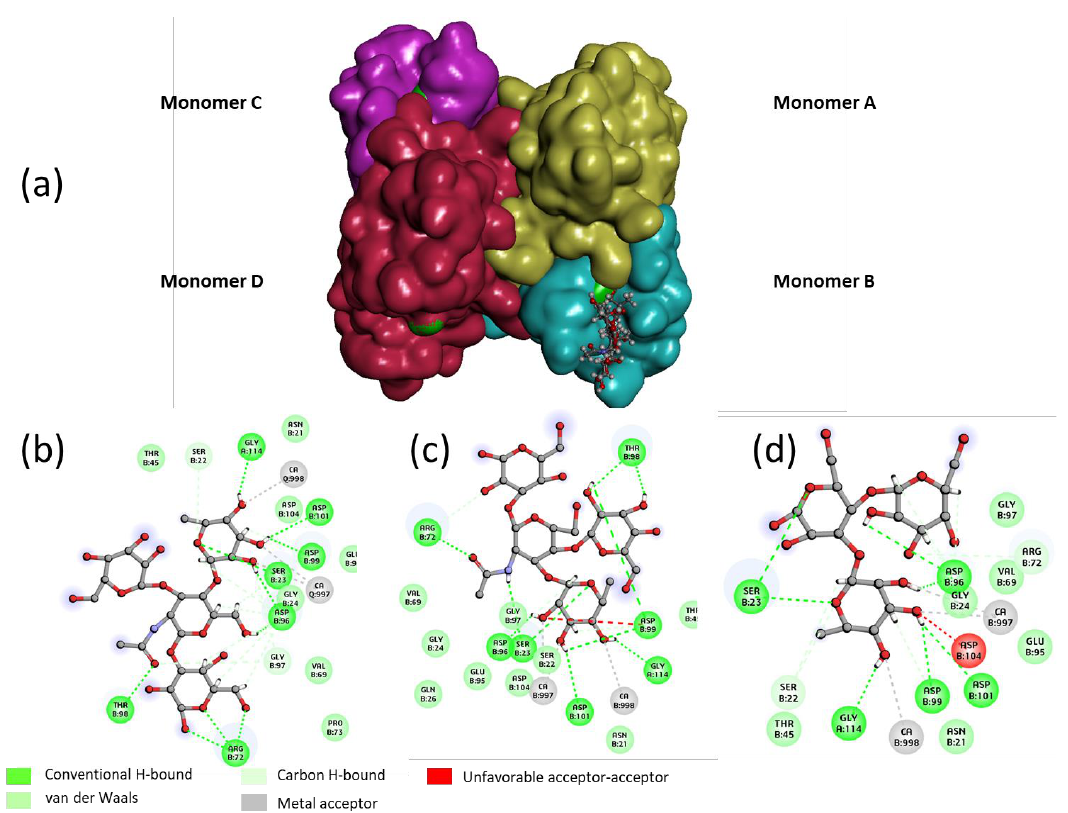
Figure 4. ( a ) Lewis a interaction with Lectin LecB tetramer (calcium ions in green). 2D diagram (Biovia Discovery Studio 2016) of the interaction of LecB tetramer with ( b ) Lewis a tetrasaccharide, ( c ) Lewis x tetrasaccharide and ( d ) 3-Fucosyllactose (3FL).